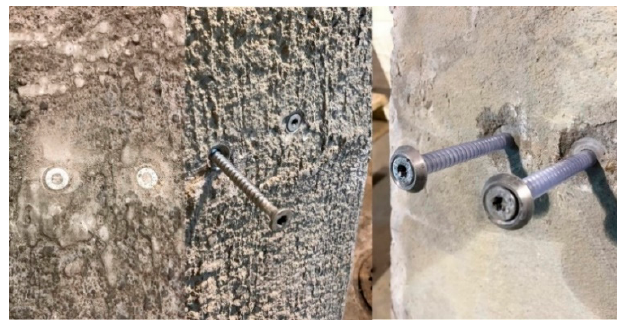
Figure 10. Screw uninstallation.